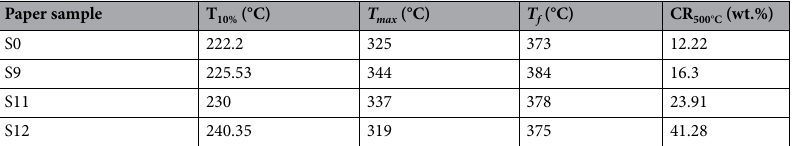
Table 4. TGA & DTG data of blank and modified printed papers. Where T 10% is the temperature where the sample losses 10% from its weight during the process, T max is the temperature corresponding to major decomposition process, T f is the temperature were the decomposition process is finished and CR 500°C (wt.%) is the Char residue percent at temperature corresponding to constant weight